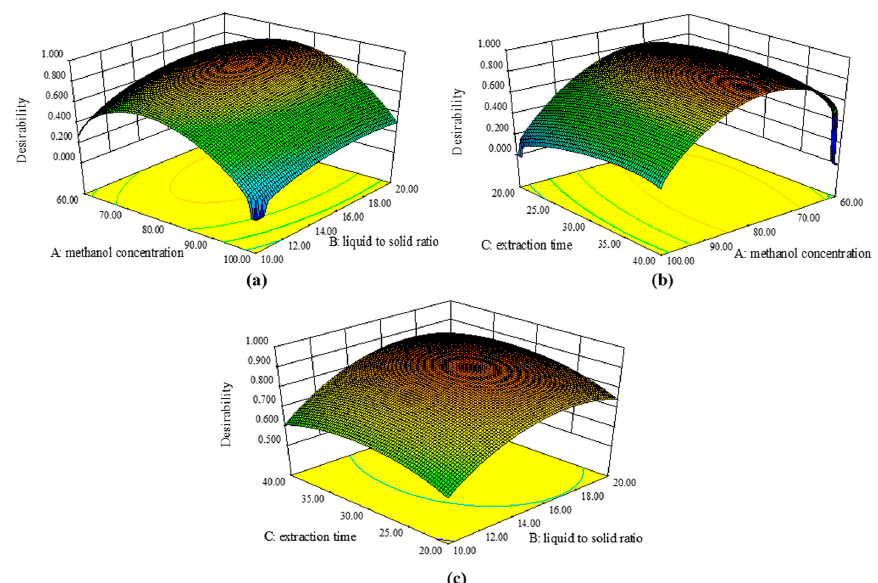
Figure 3. Response surface plots corresponding to the desirability function (maintaining one of the variables at optimum values): ( a ) methanol concentration-liquid/solid ratio; ( b ) extraction time-methanol concentration; ( c ) extraction time-liquid/solid ratio.